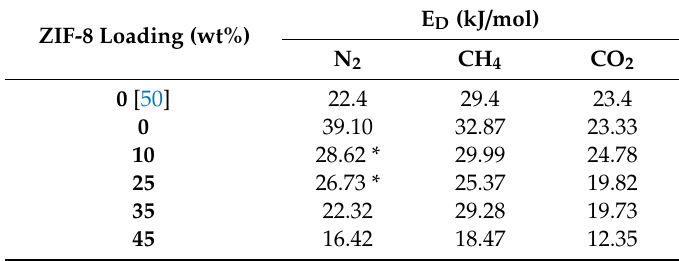
Figure 20. Di ff usivity of ( a ) CH 4 , ( b ) CO 2 , and ( c ) N 2 at di ff erent temperatures, in the ZIF-8 / PPO MMMs of di ff erent weight fractions of ZIF-8, from 0% to 45%. Table 6. Activation energy of di ff usion in the range of 35–65 ◦ C for ZIF-8 / PPO MMMs at di ff erent filler